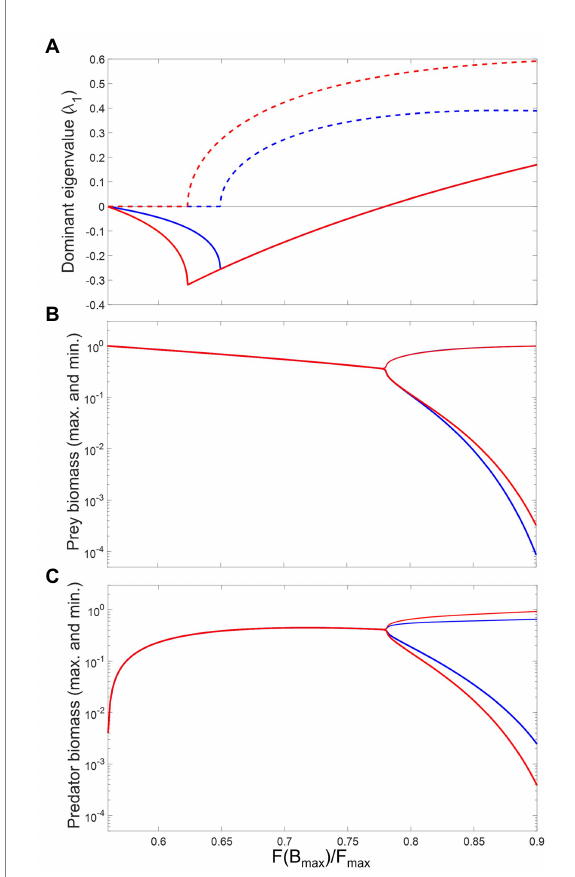
FIGURE 5 Effects of consumption saturation on the local stability and long- term biomass levels of prey and predator in the modified Rosenzweig–MacArthur model (Equation 6a and 6b). The x-axis measures consumption rate at a reference prey biomass ( max B , their carrying capacity), relative to maximum consumption ( max F ). Blue versus red lines represent the absence versus the presence of a metabolic response, respectively. (A) plots the real (continuous lines) and imaginary (dashed lines) parts of the dominant eigenvalue of the Jacobian matrix. (B) and (C) are bifurcation plots showing long term maximum and minimum biomass of prey and predator, respectively. Other parameter values are: 1